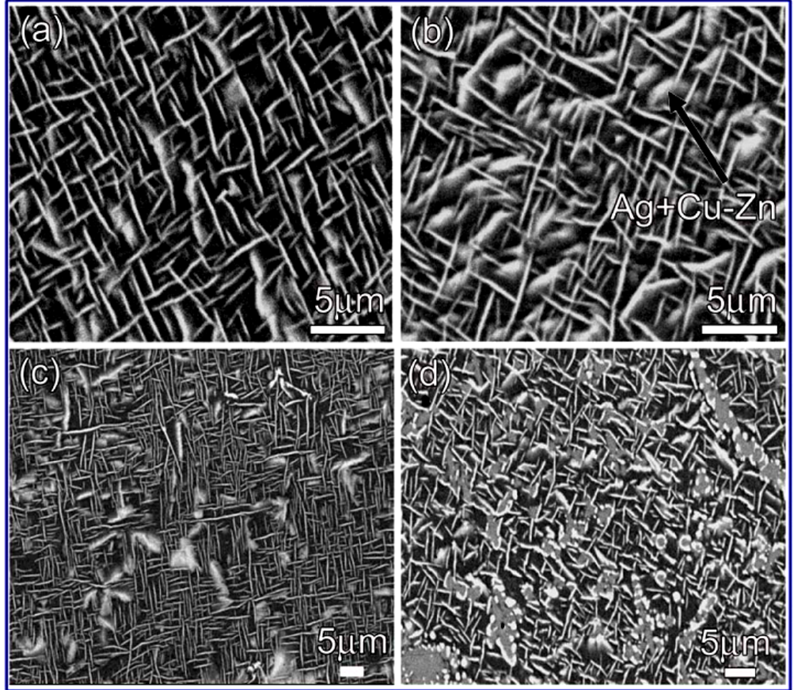
Figure 6. BSE images of Ag-Cu-Sn filler metals with ( a ) 1.5%, ( b ) 2.2%, ( c ) 3%, and ( d ) 4% Sn [22].